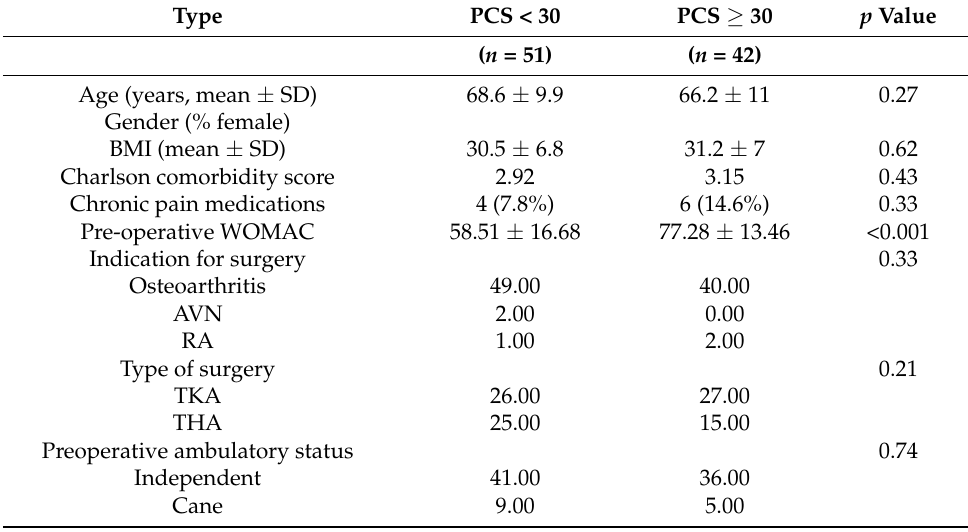
Table 1. Pre- and postoperative characteristics of cohort subjects, pain catastrophizers and non-